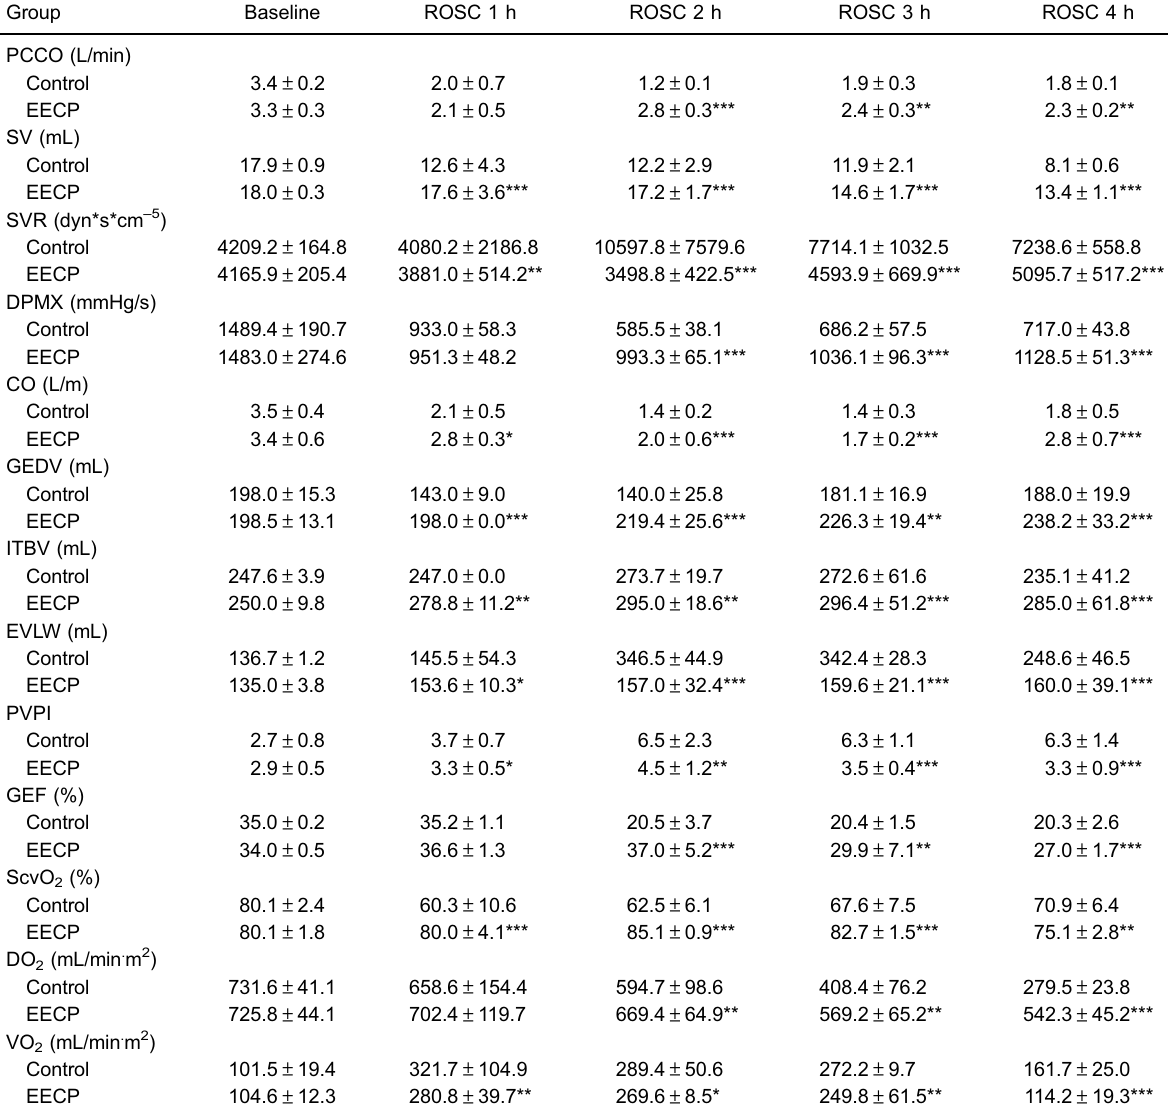
Table 3. Comparison of PiCCO2 parameters between Control and enhanced external counterpulsation (EECP) groups after return of spontaneous circulation (ROSC). Group